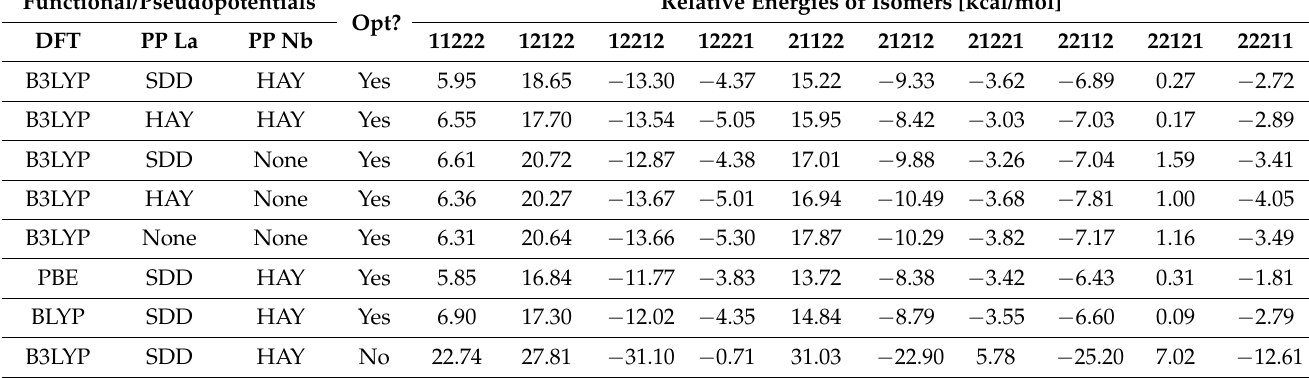
Table 3. Relative energies of the ten occupational isomers of LNT calculated with different